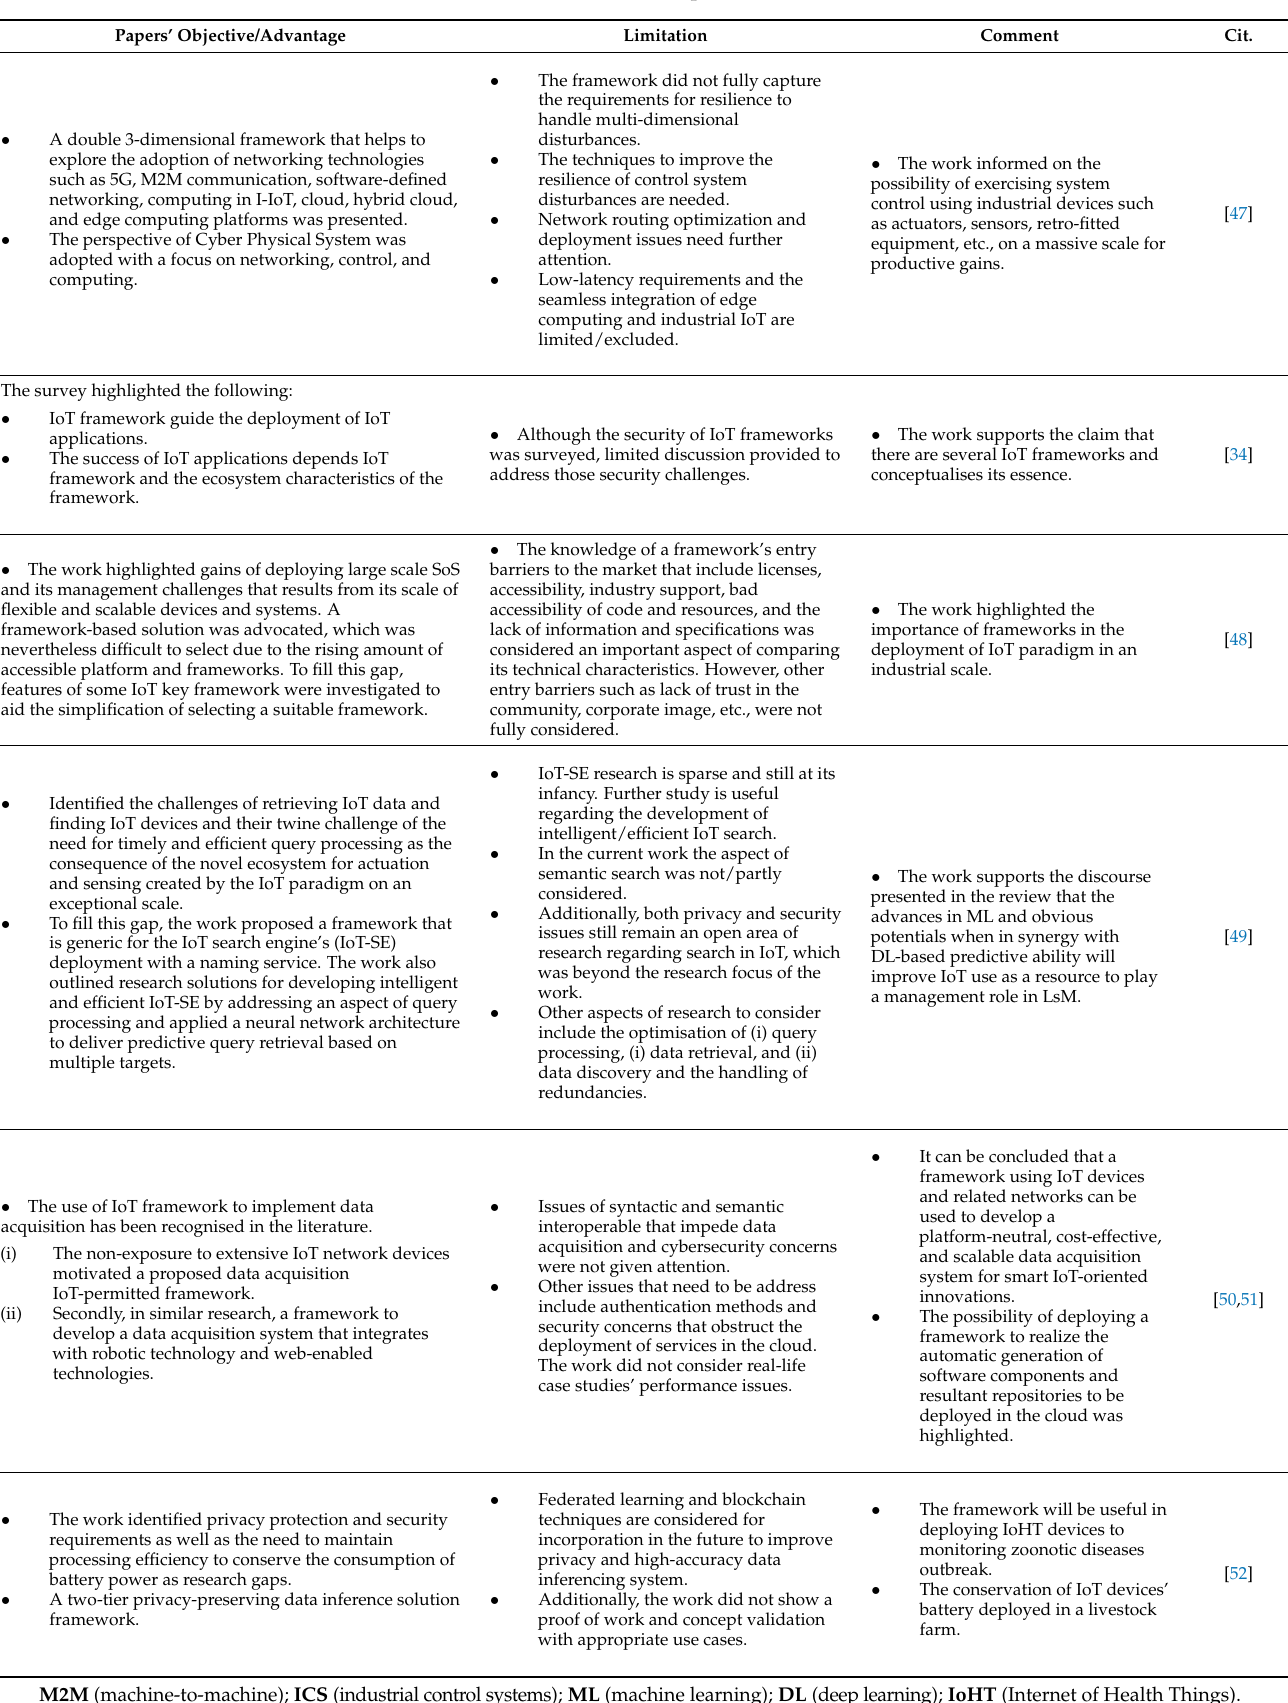
Table 2. Presents a summarized comparison of IoT